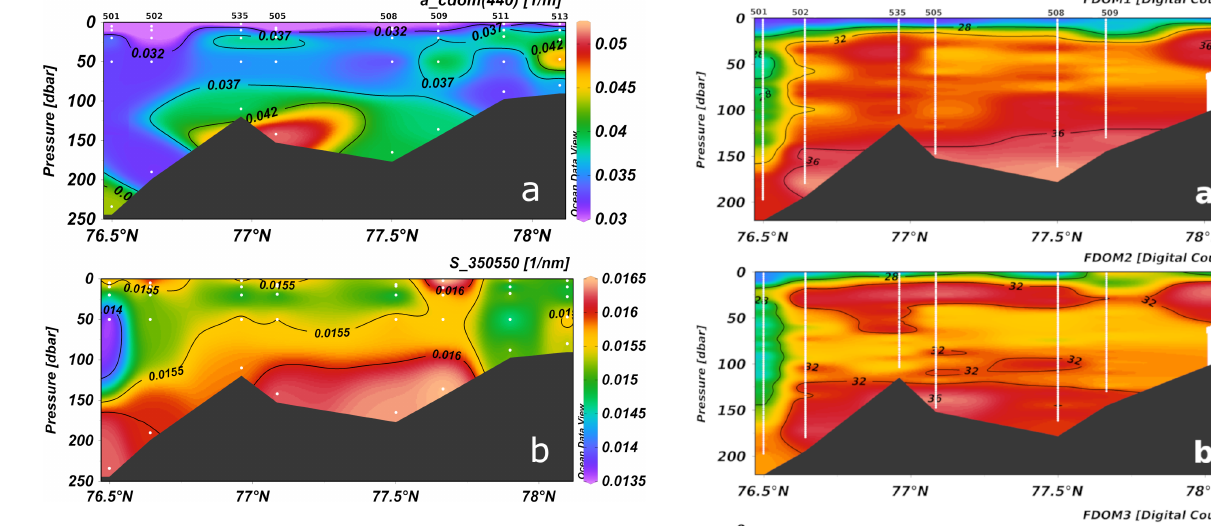
Figure 6. Section plots of (a) CDOM absorption at 440nm and (b) the spectral slope of CDOM absorption in the wavelength range 350 to 550nm from water samples. Data locations shown with white dots. Plots are made with Ocean Data View (Schlitzer, Reiner, Ocean Data View, https://odv.awi.de/, last access: 30 January 2022).